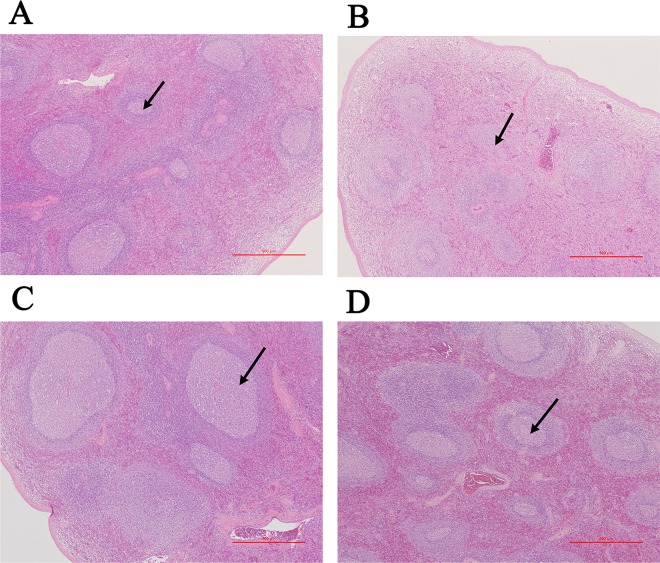
Microscopic evaluation of the spleens of monkeys fed on diets containing GM rice or non-GM rice.Microscopic evaluation of the spleen (40×) in monkeys in the non-GM rice group (A), positive control group (B), 17.5% genetically modified rice (GM rice) group (C), and 70% GM rice group (D). The spleens of monkeys in the positive group (B) showed atrophy and slightly fewer lymphocytes in the white pulp.